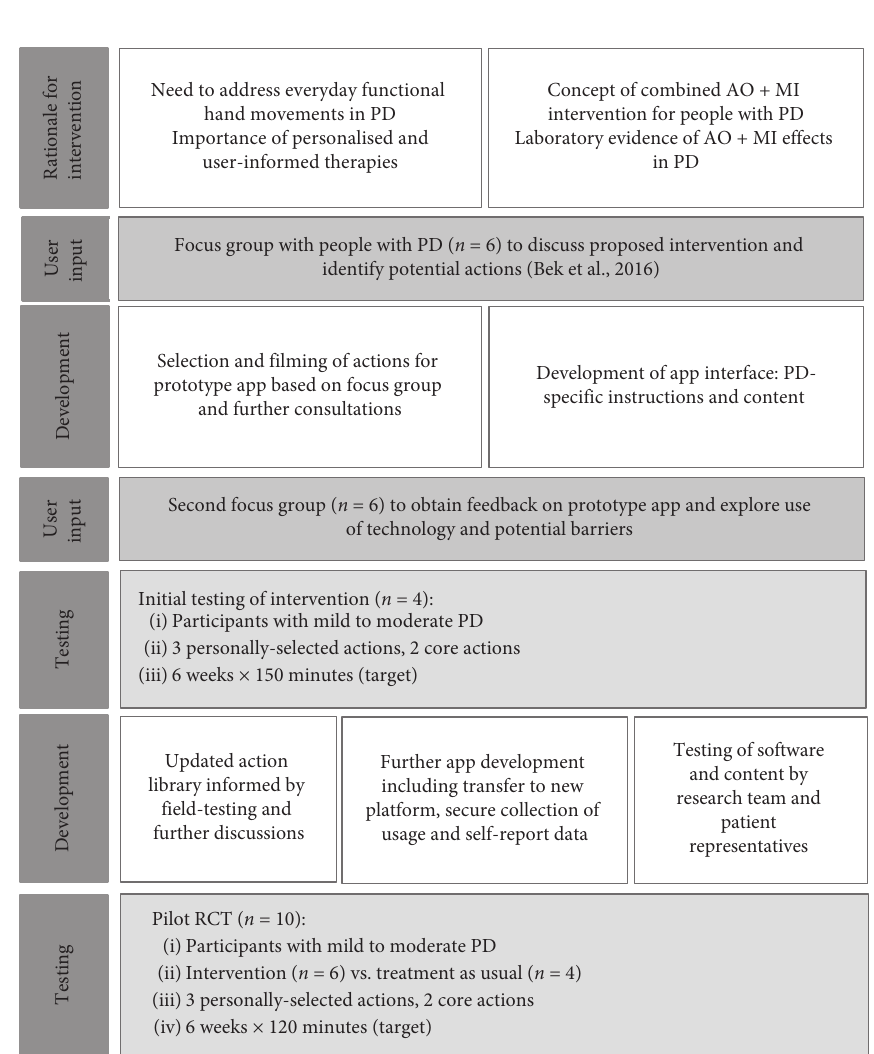
Figure 1: The intervention development process.